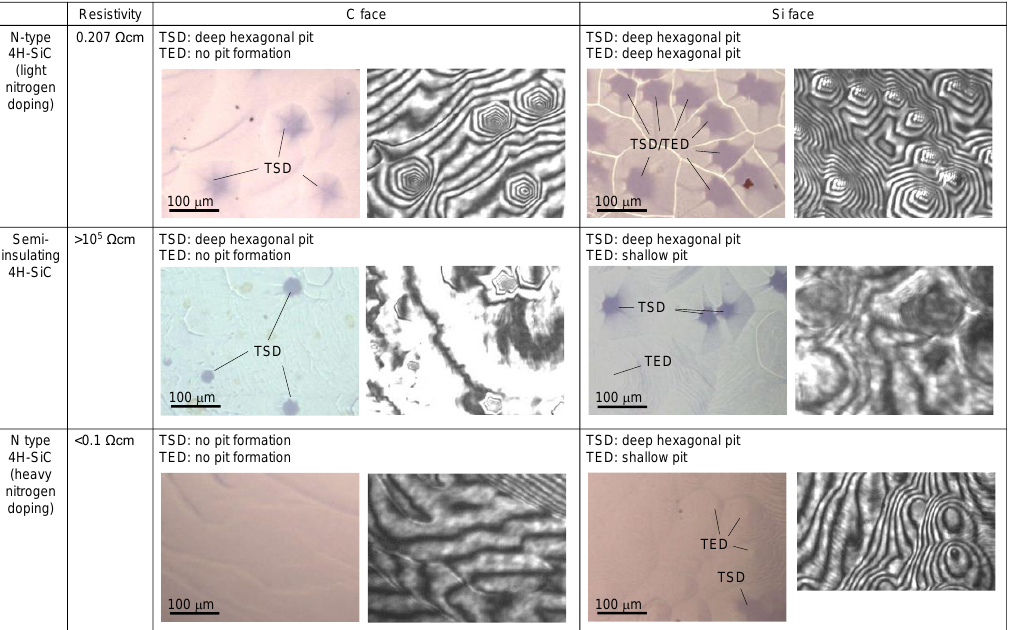
Figure 6. Summaries of correlation between dislocation and dissolution pit together with interface morphologies during SiC dissolution into Fe-Si alloy at ~1500 K. Bright-field image ( left ) and cor- responding interference image ( right ) are shown for each condition. All the photos indicate the morphology 10 s after the beginning of dissolution. The relationships between dissolution pit and dislocations were clarified by KOH